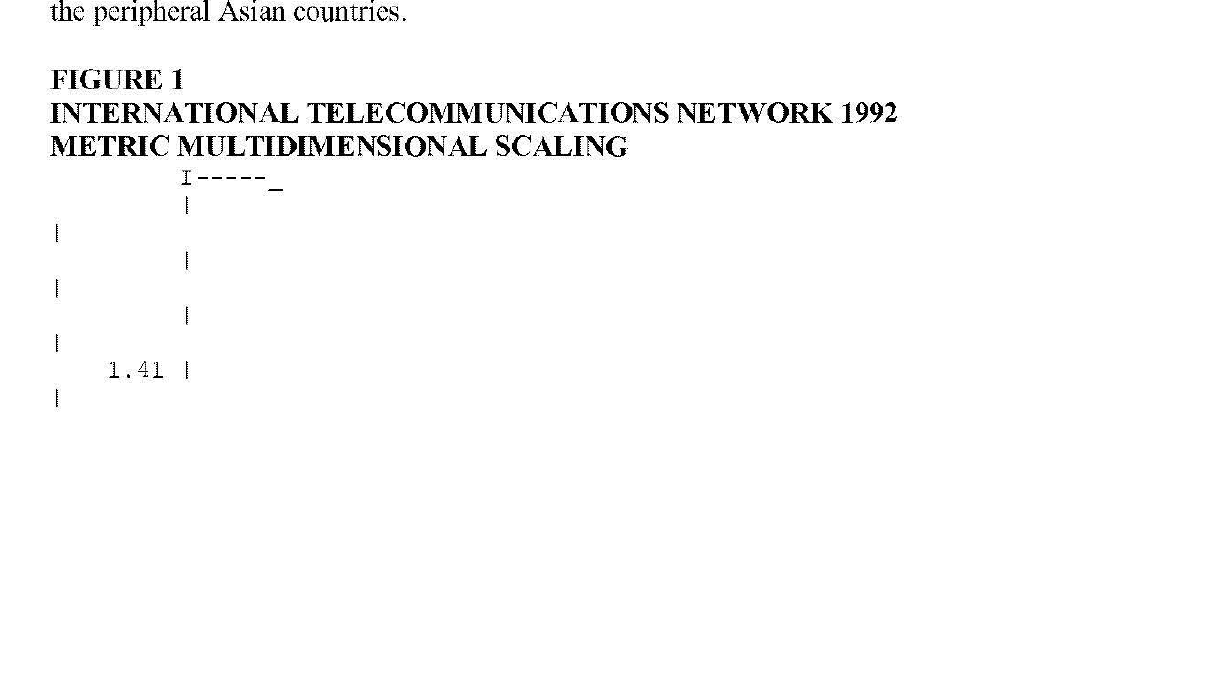
FIGURE 1 INTERNATIONAL TELECOMMUNICATIONS NETWORK 1992 METRIC MULTIDIMENSIONAL